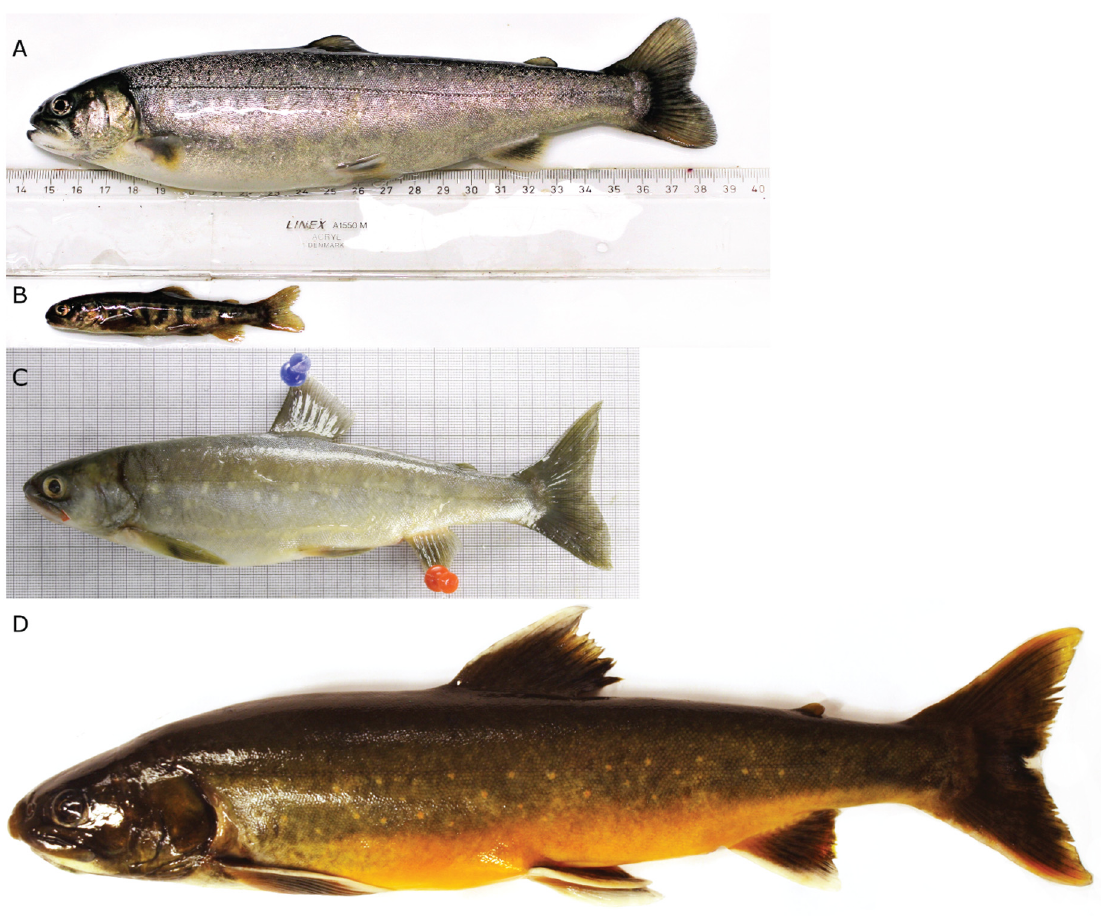
Figure 1. The Arctic charr morphs used in this study. Adult individuals of the four morphs studied here, A ) the Holar aquaculture charr, B ) the small benthic charr, C ) the planktivorous charr D ) and the large benthic charr. The latter three all come from Lake Thingvallavatn and were sexually ripe. The morphs differ in size at maturation, body and head shape - mainly lower jaw and length of maxilla and colour pattern in the